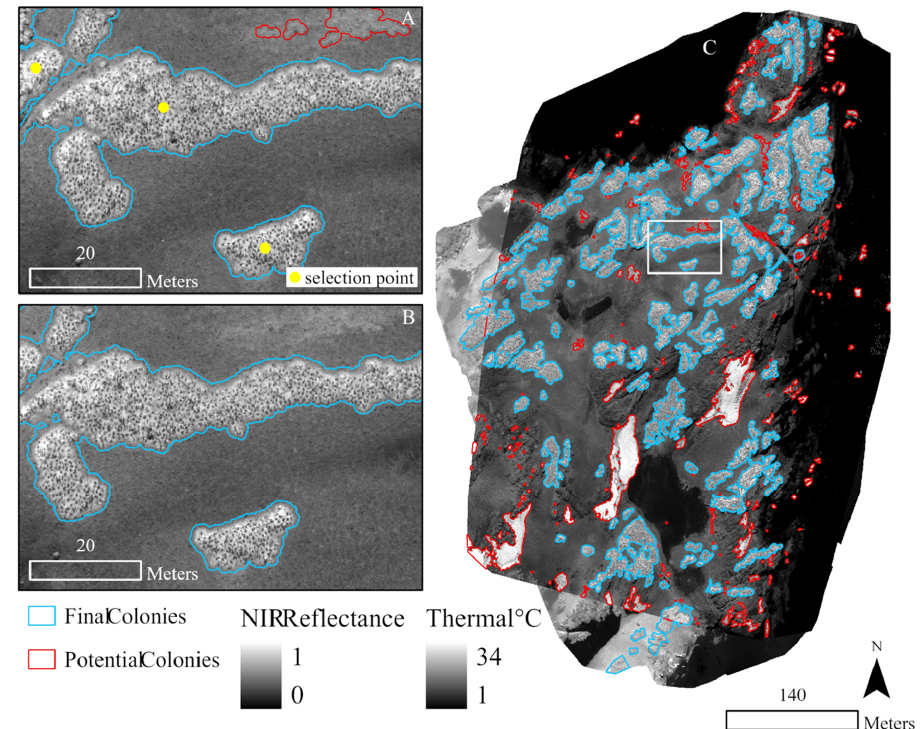
Figure 2. All potential colonies isolated using multispectral imagery at the Avian Island study site. Image ( C ) shows the multispectral image over the thermal image. Panel ( A ) shows how user-generated points are used to select correctly isolated colonies. Panel ( B ) shows in the area from panel ( A ) with only the correctly isolated colonies displayed. The colonies outlined in blue are the final colonies used to extract the colonies from the thermal imagery. The colonies outline in red are colonies that were incorrectly isolated by the workflow. Manually drawn colonies are visible (outlined in blue) on the bottom and left edges of the image ( C ). These colonies were drawn because the extent of the thermal image was greater than that of the multispectral image.